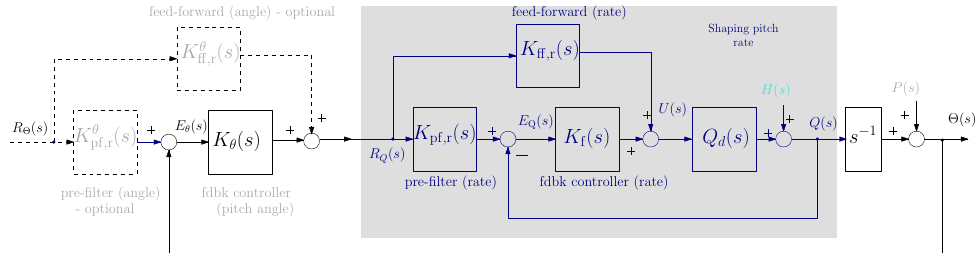
Figure 6. UAV pitch angle control loop (disturbance channel is shown) for the proposed control